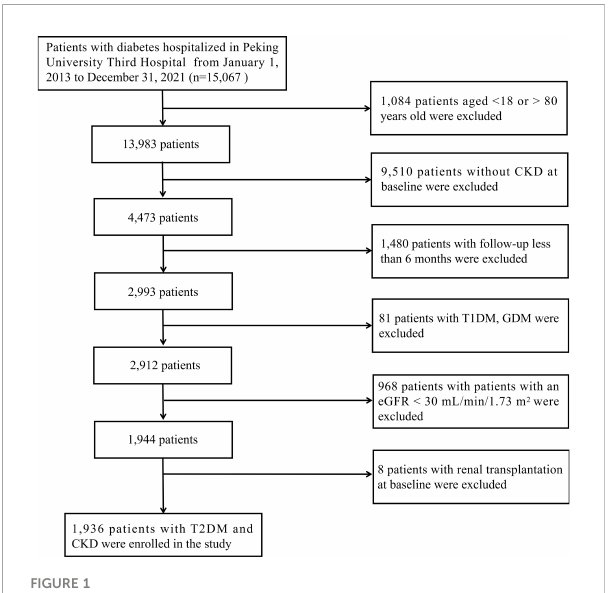
FIGURE 1 Enrollment fl owchart for the research